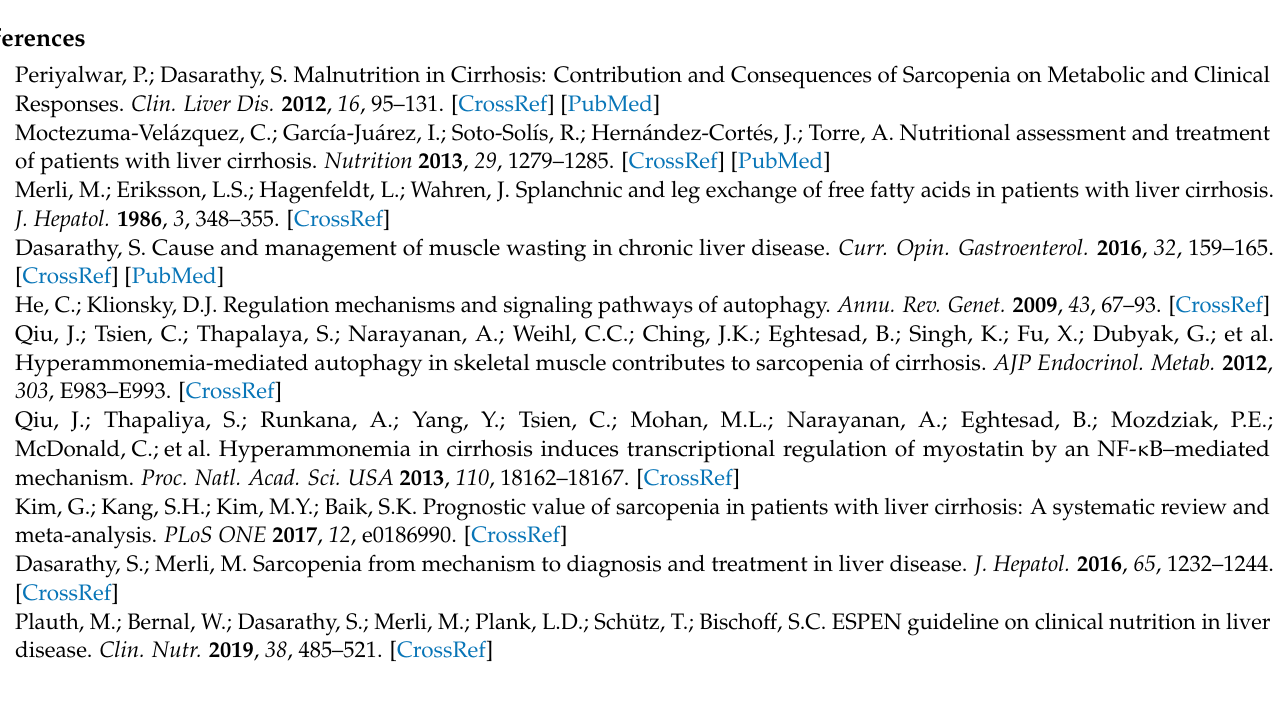
Table S2: Anthropometric characteristics at baseline; Table S3: Laboratory tests at baseline; Table S4: Differences in clinical and body composition characteristics between compliers and